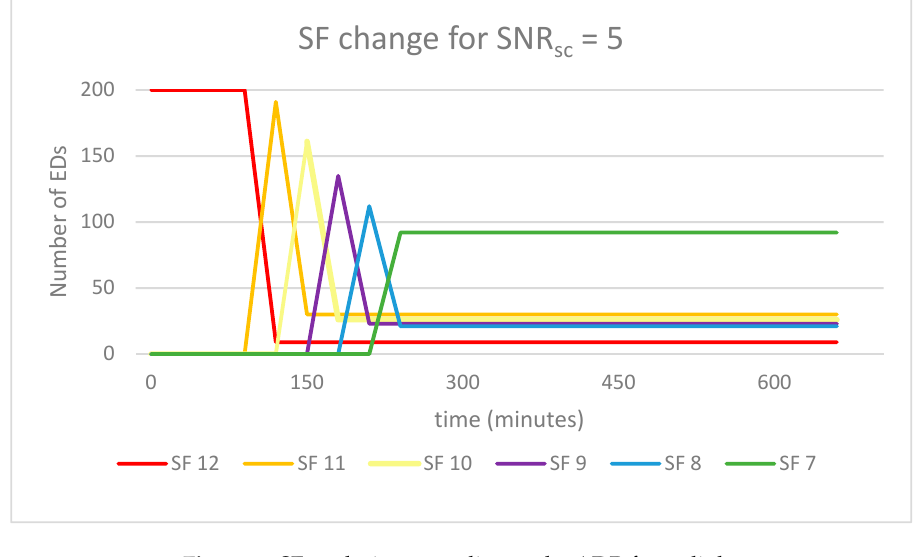
Figure 8. SF evolution according to the ADR for uplink. Table 6. Message statistics for simulated configurations.